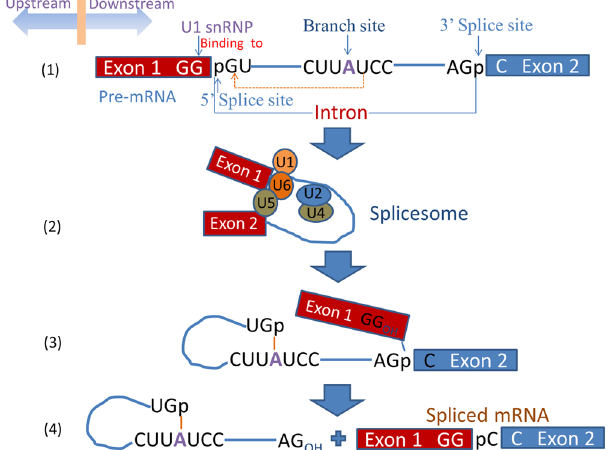
Figure 1. Sketch map showing the steps about the pre-mRNA how to become a mature messenger RNA.